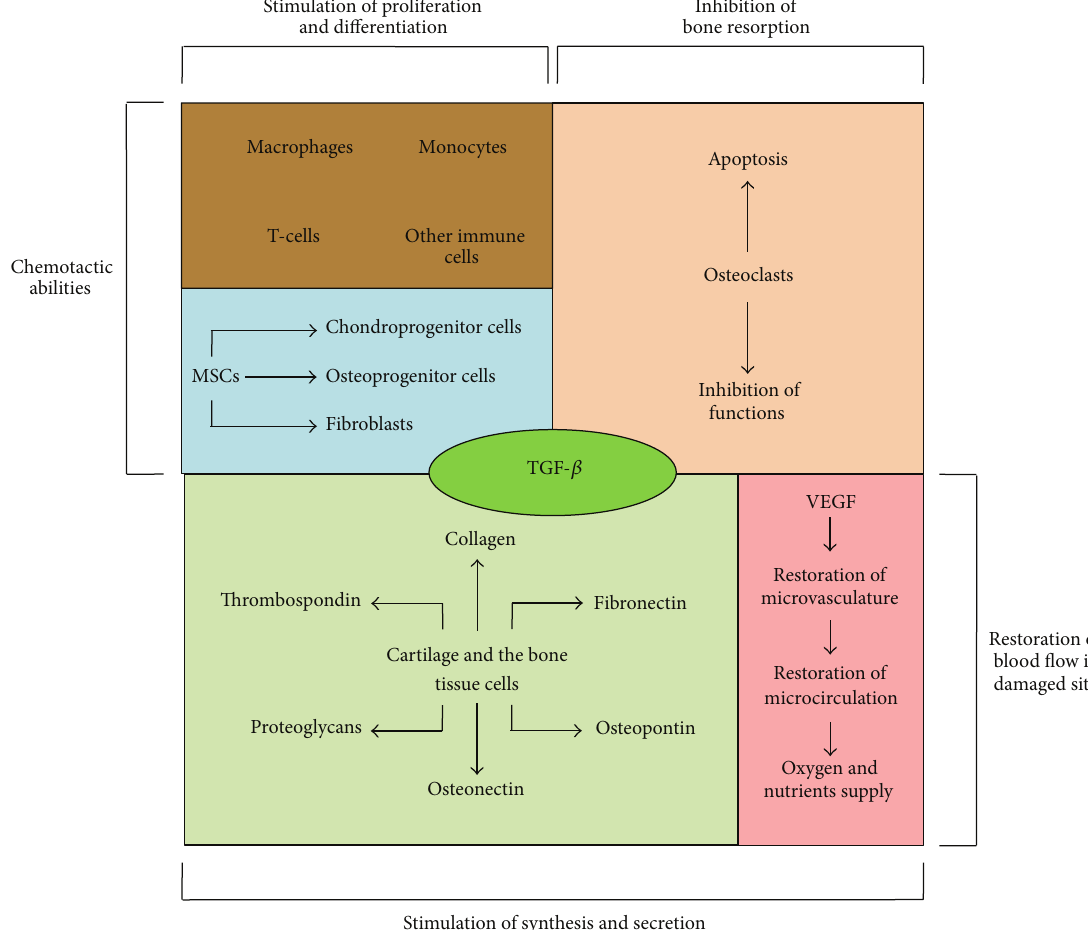
Figure 4: A schematic representation of TGF- 𝛽 interactions and effects in fracture site. TGF- 𝛽 : transforming growth factor beta; MSCs: mesenchymal stem cells; VEGF: vascular endothelial growth